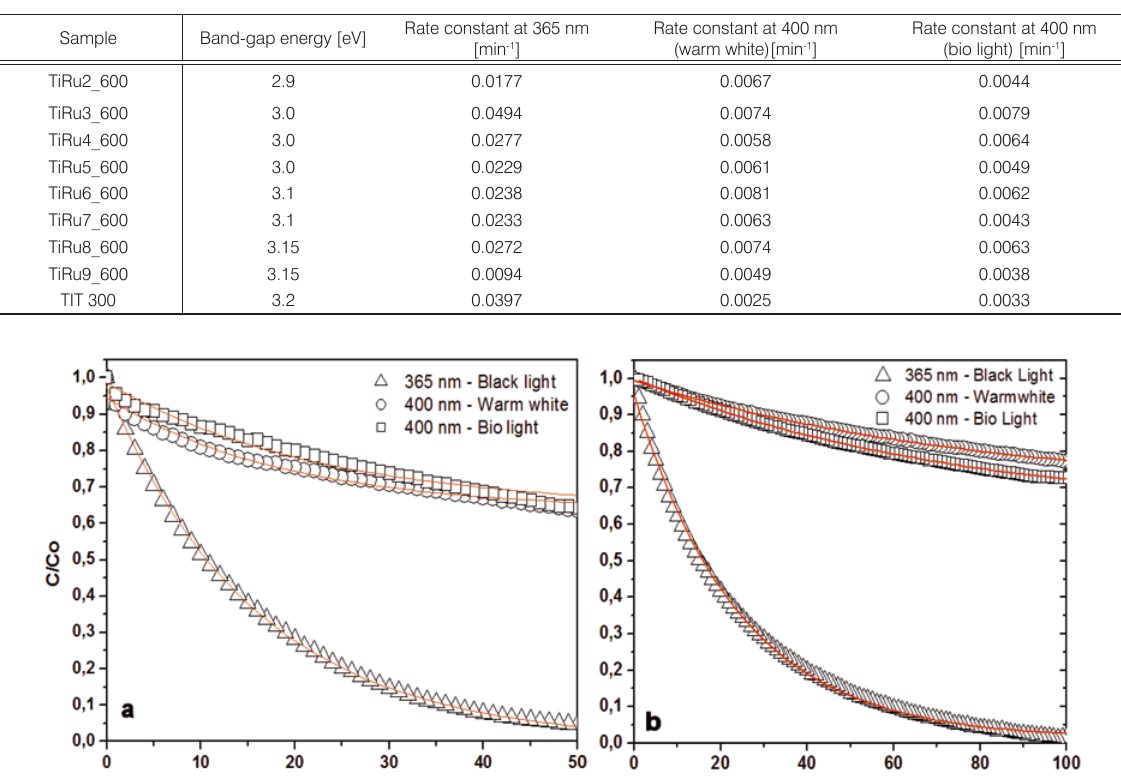
Figure 9. Photodegradation of Orange II during irradiation at 365 nm, 400 nm (warm white light) and 400 nm (bio light); (a) TiRu3_600, (b) TIT 300.